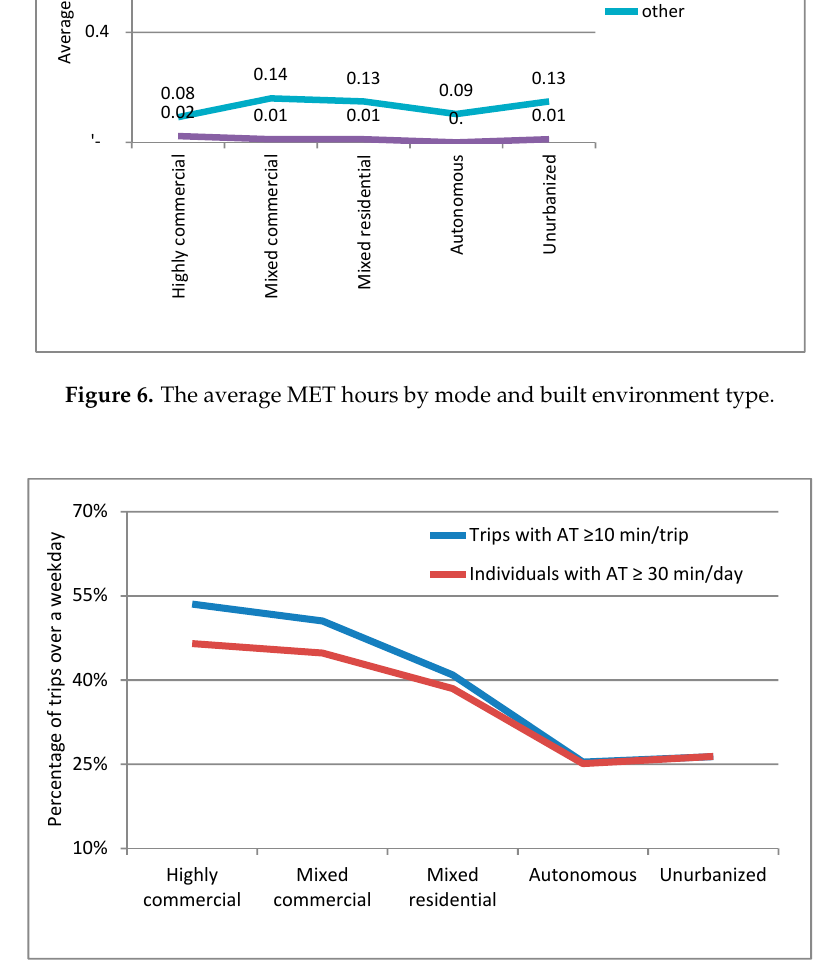
Figure 7. Percentage of trips by built environment where active travel min are at least 10 min and the percentage of respondents achieving at least 30 min accumulated active travel min by built environment type.